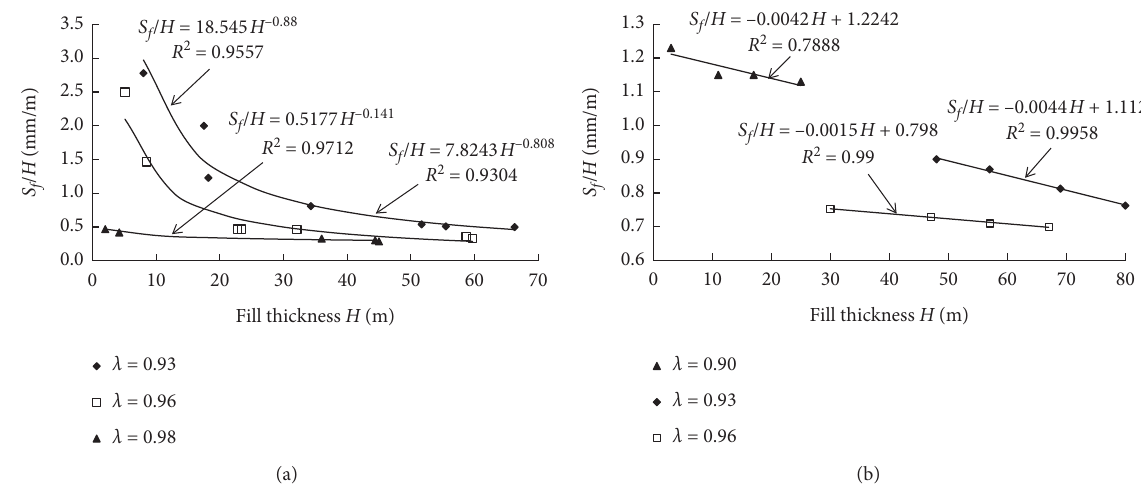
Figure 17: Relationship between S f /H and H under different average compaction degrees. (a) During the intermission period (1143.6m). (b) During the completion period